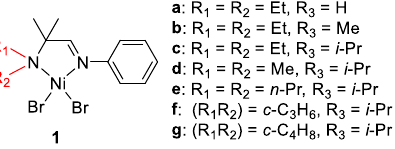
Figure 2. Amine – imine nickel complexes with different substituents.